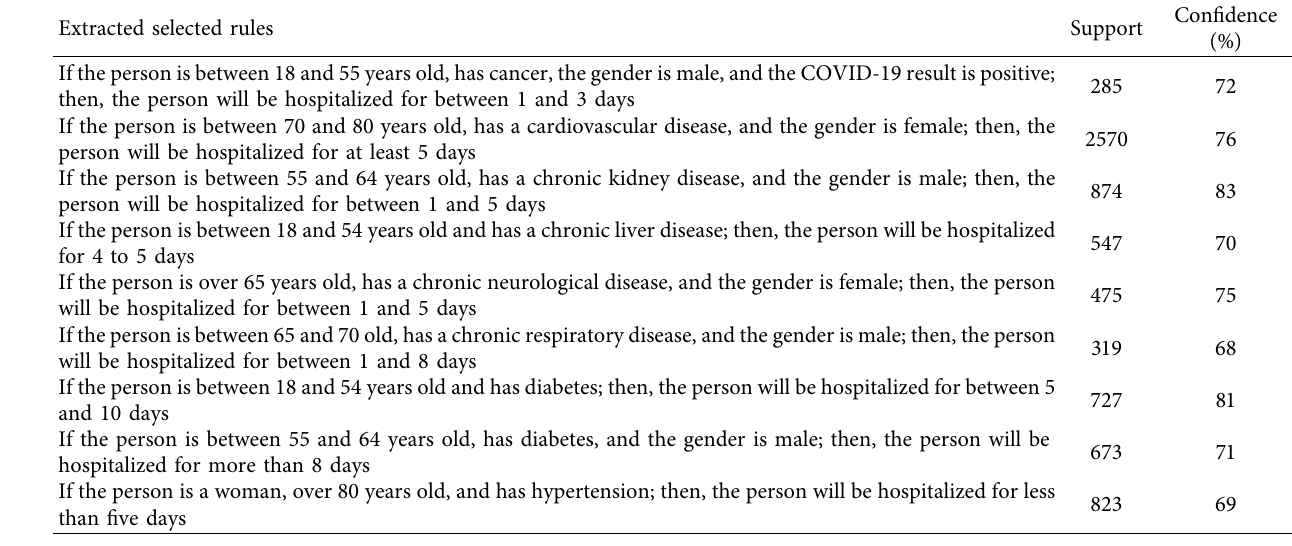
Table 4: Extracted selected rules regarding the prediction of the hospitalization time of COVID-19 patients. Extracted selected